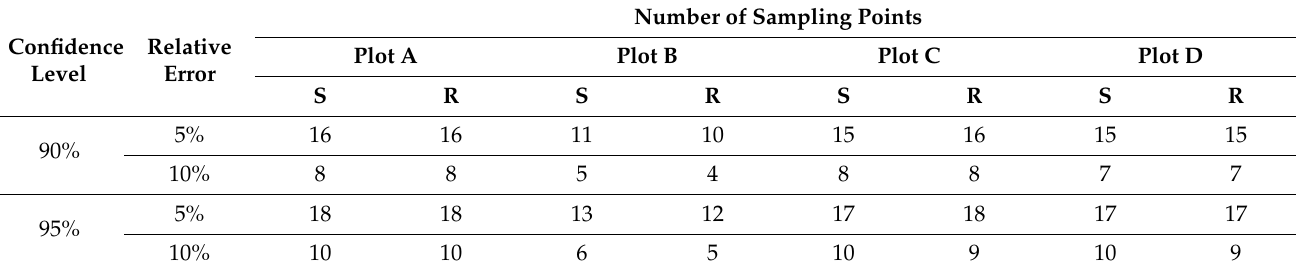
Table 2. The number of sampling points required under different accuracy by statistical sampling (referred as “S” in Table 2) and the random combination method (referred as “R” in Table